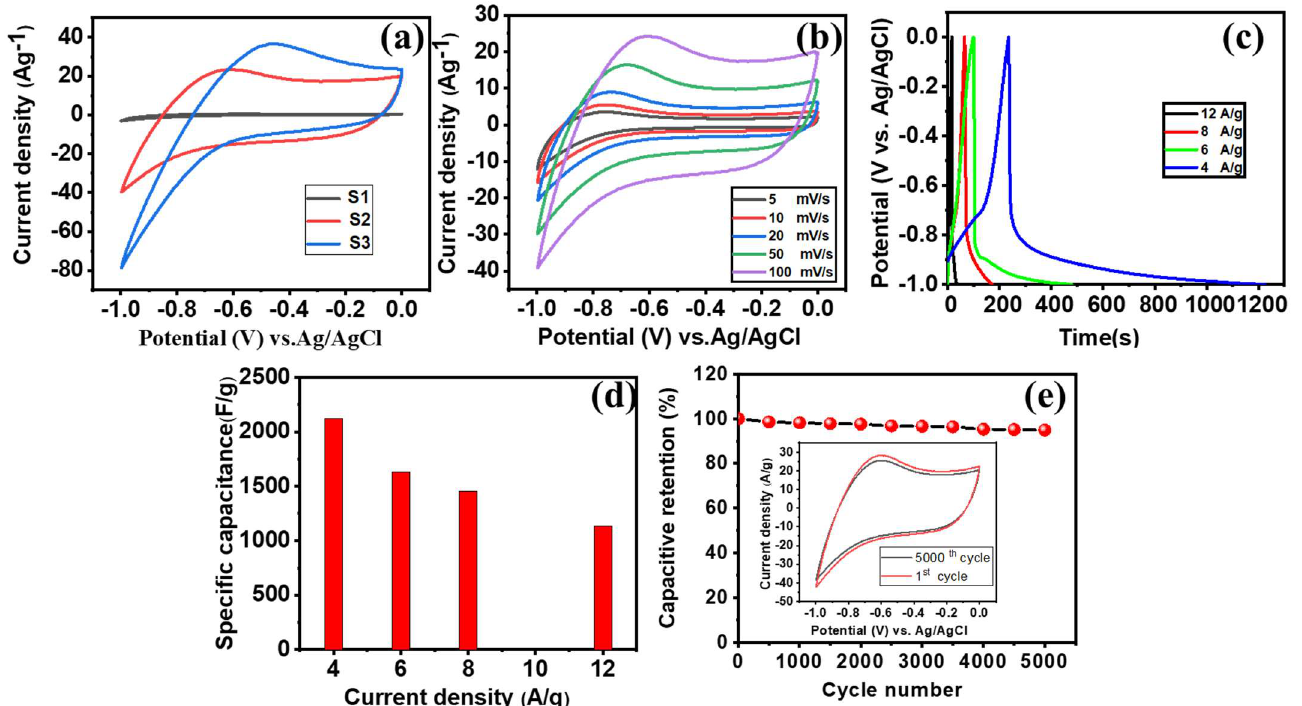
Figure 4. CV study for ( a ) S1, S2, and S3 samples, and ( b ) different scan rates; ( c ) GCD curves at different current densities; ( d ) plot of specific capacitance vs. current density; ( e ) plot of capacity retention vs. cycle number and inset shows the stability study at 5000 CV cycles for the α-Fe 2 O 3 thin film.